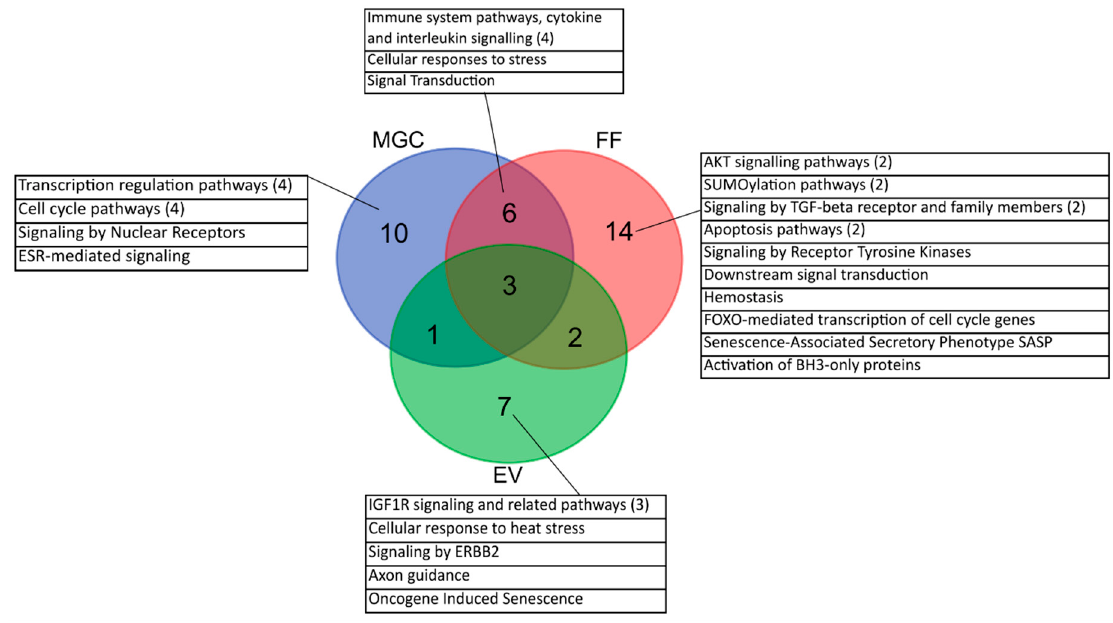
Figure 7. Number of Reactome pathways over-represented for miRNAs that are more abundantly expressed in PCOS patients compared to the fertile control group in each sample type. Numbers in brackets refer to combined pathways with similar outcome. EV—extracellular vesicles, FF—cell-free follicular fluid, MGC—mural granulosa cells.